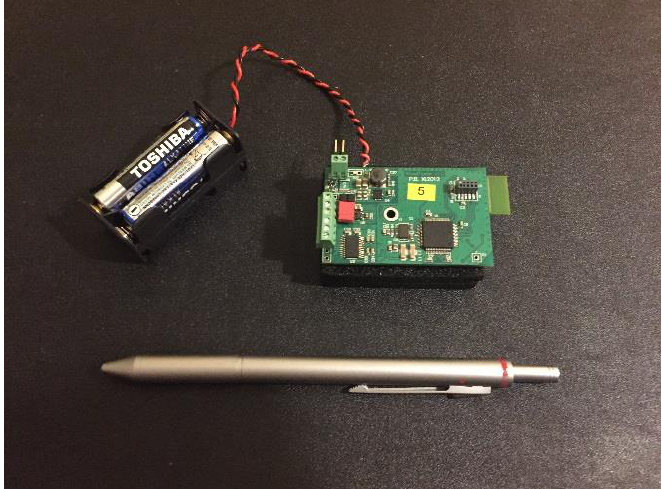
Figure 3. The heart of the microprocessor data transfer system, used in the wheel sensor system.